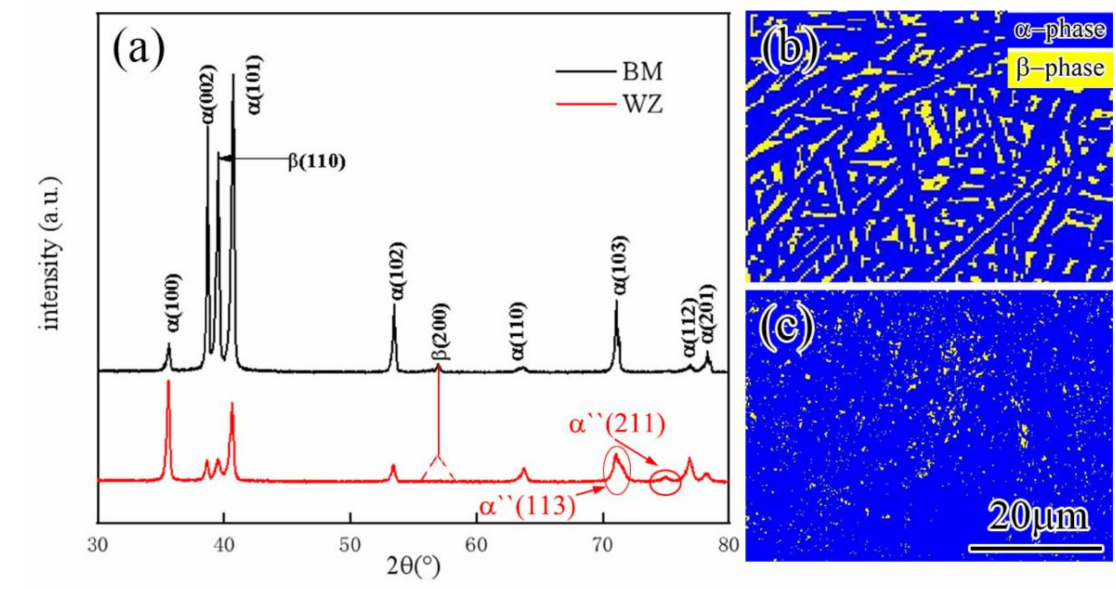
Figure 7. ( a ) XRD patterns of BM and WZ of the IFW joint; ( b ) EBSD phase mapping of BM; ( c ) EBSD phase mapping of